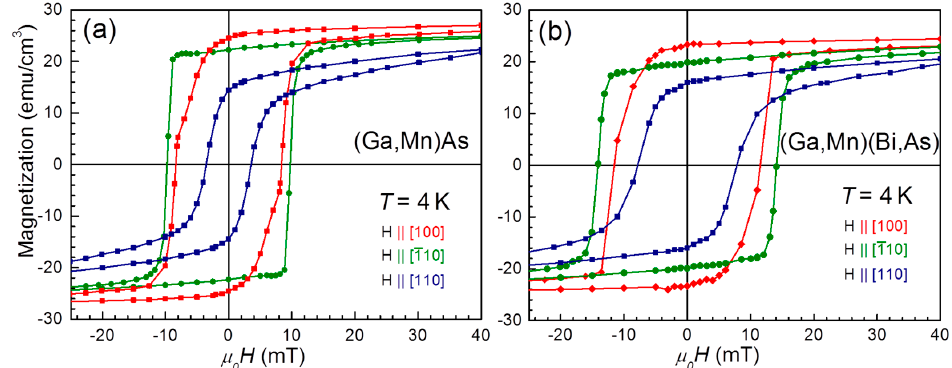
Figure 5. In-plane magnetic hystereses of ( a ) (Ga,Mn)As and ( b ) (Ga,Mn)(As,Bi) layers at temperature T = 4 K. Magnetic field H has been applied along three main in-plane directions, as described in the panels.